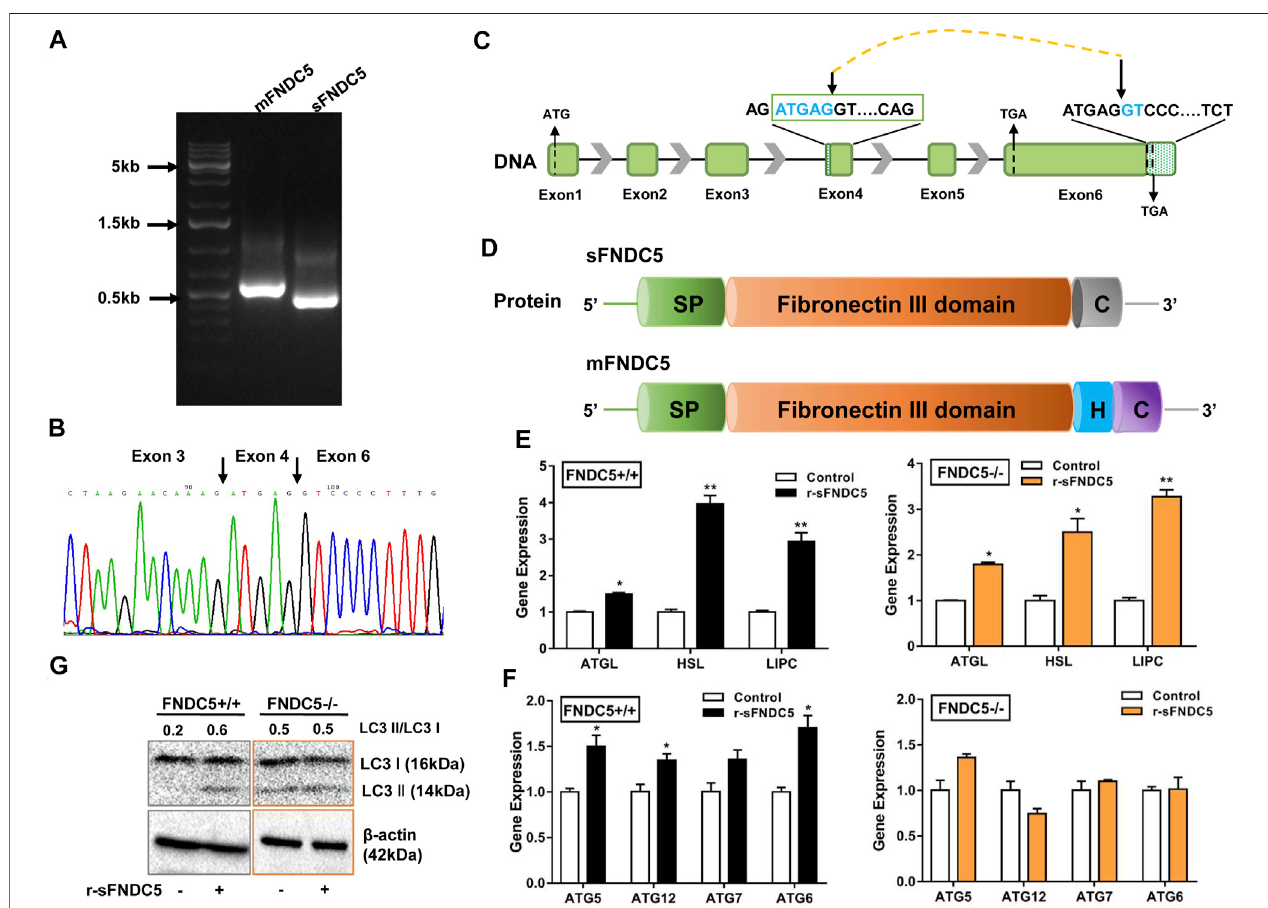
FIGURE3| Asecreted isoform ofFNDC5 (sFNDC5) mediatesGLP-1 induced lipolysisand autophagyof β cells. (A) INS-1 cells expressed along( mFNDC5 ) and a short FNDC5 ( sFNDC5 ) transcript in agarose analysis. (B) Sequencing chromatograph of the novel secreted FNDC5 isoform. (C , D) Schematic representation of the gene and protein structure of sFNDC5 and mFNDC5. SP, signal peptide; H, hydrophobic transmembrane domain; C, C-terminal domain. (E,F) r-sFNDC5 (50 nM) induced the expression of lipolysis genes but not autophagy-related genes in FNDC5 KO β Lox5 cells. Wild-type cells were used as the control. Cells were treated with r-sFNDC5 (50 nM) for 16 h ( n (cid:1) 3). (G) r-sFNDC5 (50 nM) induced the expression of LC3 I/II in wild type but not FNDC5 KO β Lox5 cells. Cells were treated with r-sFNDC5(50 nM) for 24 h ( n (cid:1) 3). β -Actin expression was used as a control in western blottinganalysis. Each experiment wasrepeated three times. Values are mean ± SEM. * p < 0.05 and ** p <